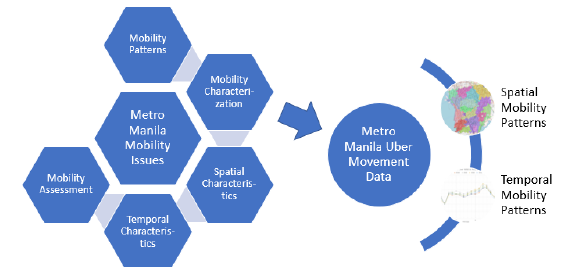
Figure 2. Conceptual framework for characterizing spatial and temporal mobility patterns